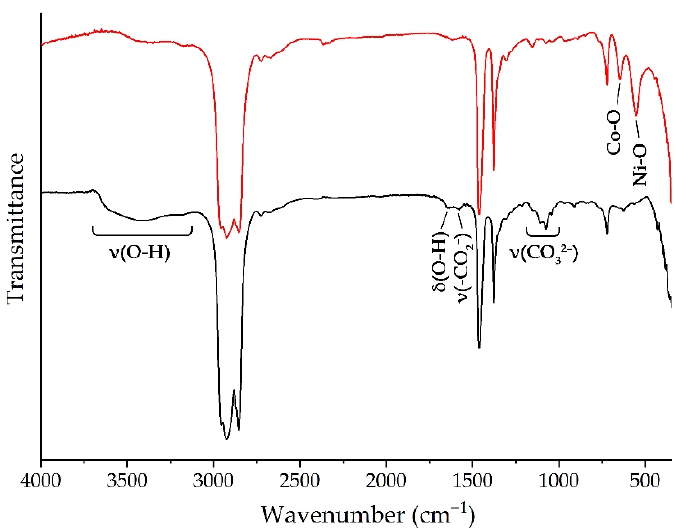
Figure 3. FTIR spectra of the semiproduct (black) and the obtained NiCo 2 O 4 nanopowder (red).